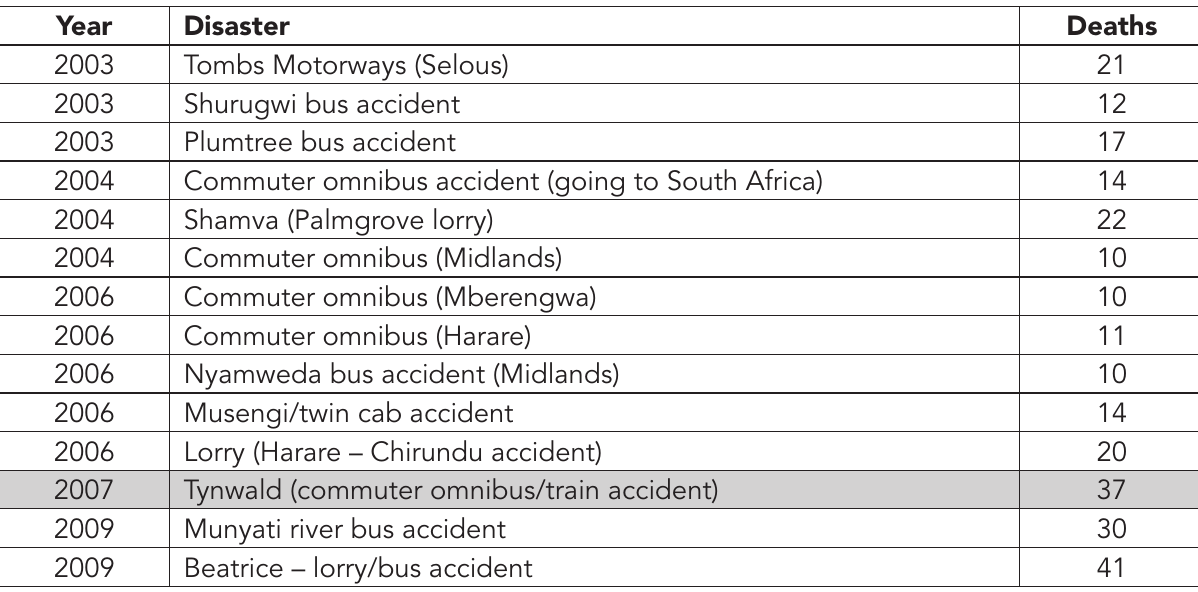
Table I: Notable road accident disasters